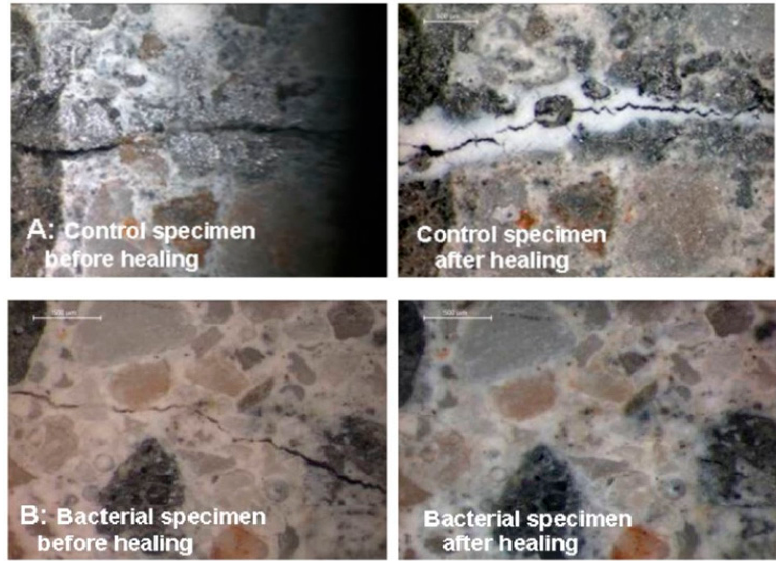
Figure 5. Images of pre-cracked control ( A ) and bacterial ( B ) concrete specimen before and after healing [6].